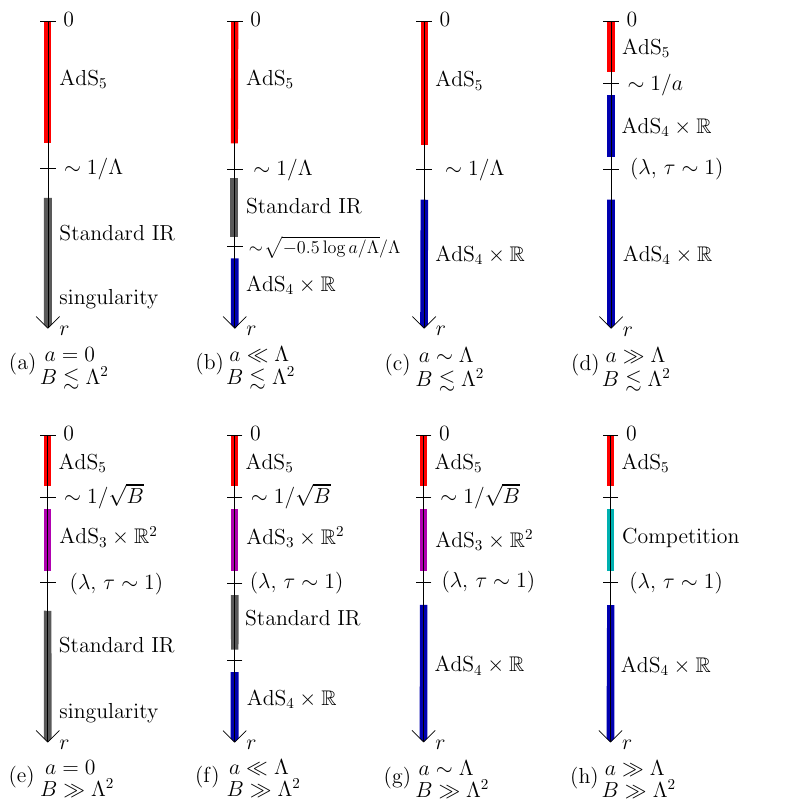
Figure 2 . The holographic RG flow in the model. We sketch the geometry for different values of a and B , as indicated in the plot, as a function of the holographic coordinate r from the UV ( r = 0 ) to the IR ( r = ∞ ). The red, gray, blue, and magenta sections show the AdS , “standard 5 IR”, AdS , and AdS 2 , given in (3.1), in (3.8), in (3.3), and (approximately) in (3.14), 4 × R 3 × R respectively. We observe that non-vanishing a removes the typical singularity at the origin of the geometry ( r = ∞ ) [26]. Transition between different regions are marked by the value of r or the scalars λ and τ . The two (approximate) AdS regimes in (d) have different radii. Effects of a 4 × R and B compete in the intermediate regime in